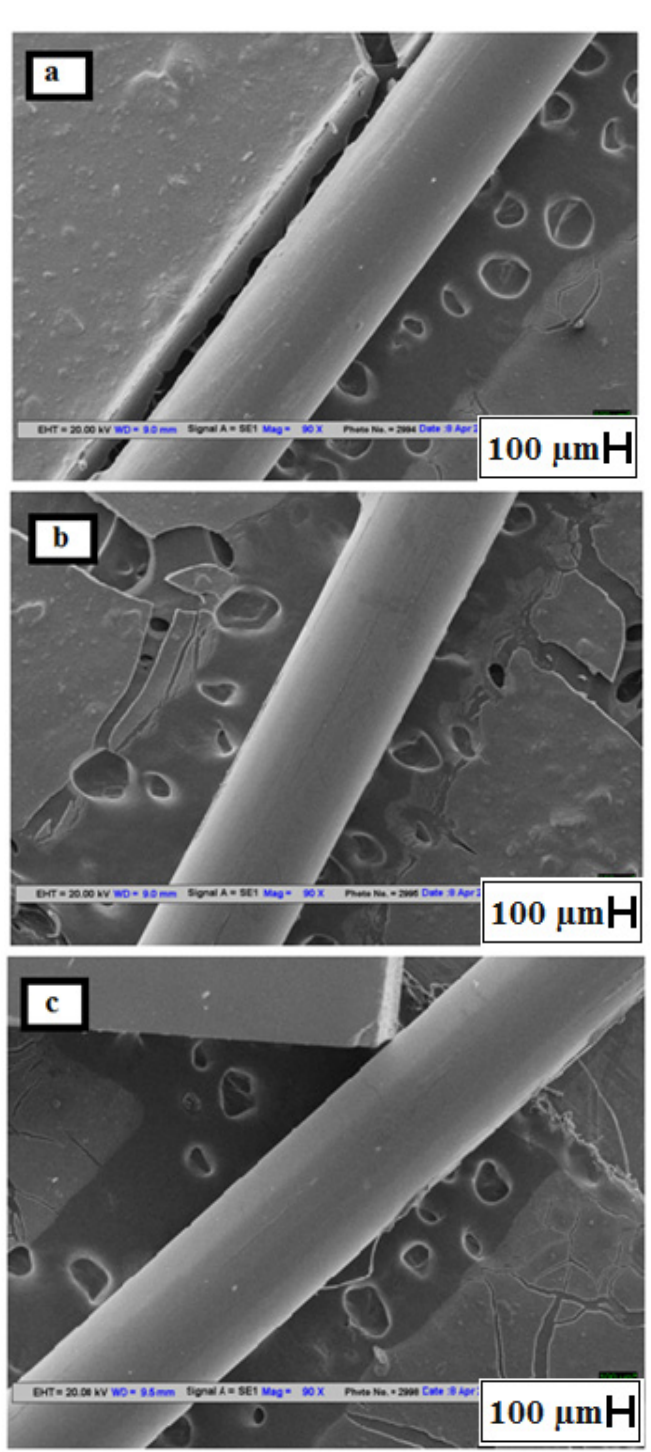
Figure 1. SEM images of ( a ) the unclad portion of bare fiber; ( b ) the silver layer coating on unclad fiber; ( c ) the zinc oxide layer coating on top of the silver layer coated unclad